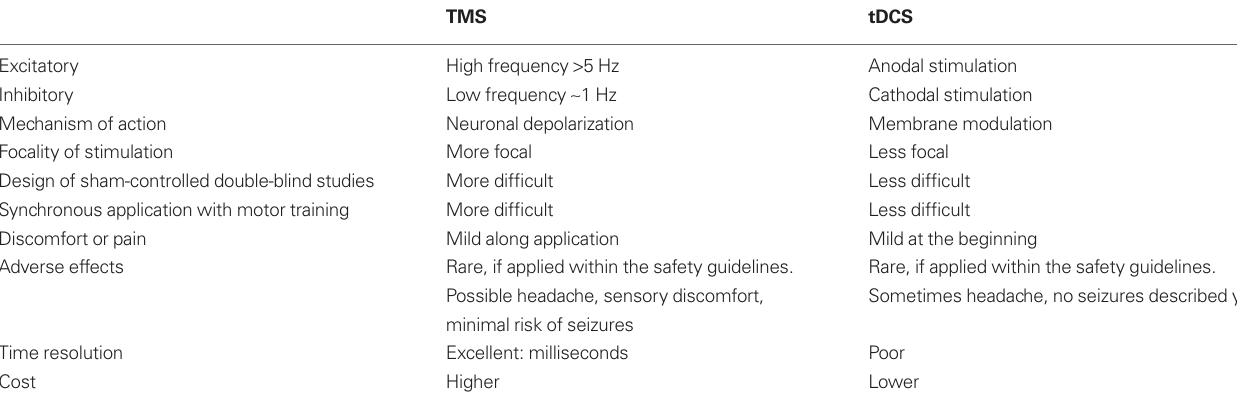
Table 1 | Summary of the main features of NIBS techniques (table modified from Gandiga et al., 2006) .